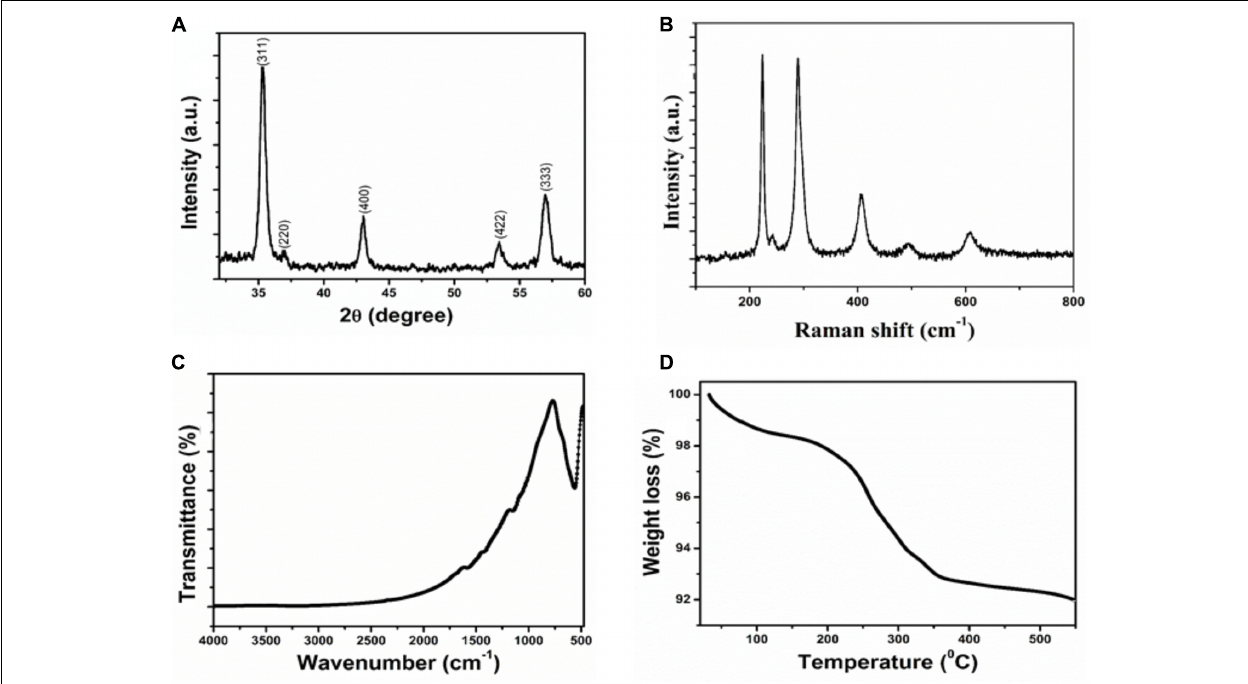
FIGURE 1 | Characterization of Iron oxide nanoparticle (A) XRD patterns (B) Raman spectra (C) FTIR spectra (D) Thermogravimetric analysis.